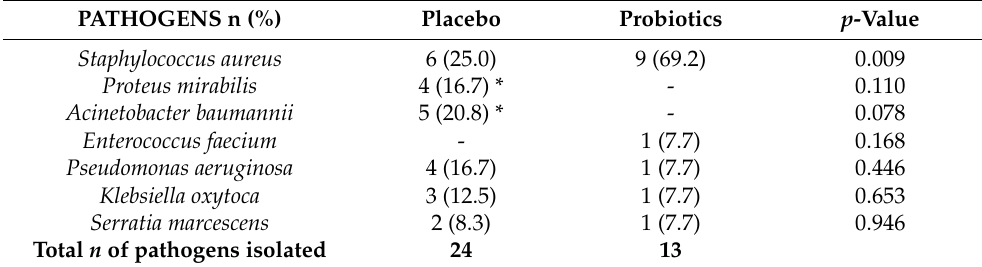
Table 5. Number of pathogens isolated from the surgical traumas. PATHOGENS n